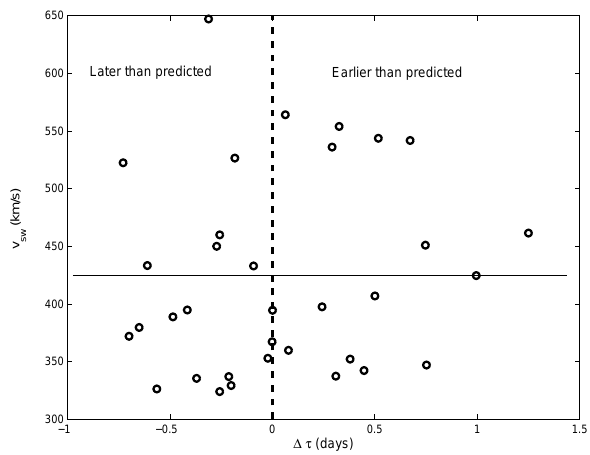
Fig. 4. The difference between the predicted and observed transit times to 1AU ( 1τ ) against solar wind speed upstream of the ICME. Positive (negative) values of 1τ correspond to ICMEs that arrive earlier (later) than predicted. The solid horizontal line shows the average upstream solar wind speed of 427km/s. There does not appear to be any correlation between the late/early arrival of ICMEs and the upstream solar wind